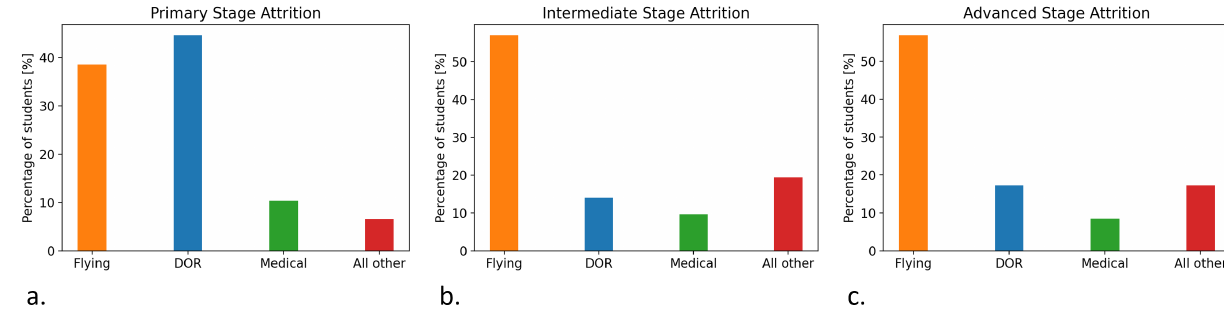
Figure 2. Distribution of student attrition, by reason for attrition, during ( a ) primary, ( b ) intermediate, and ( c ) advanced training